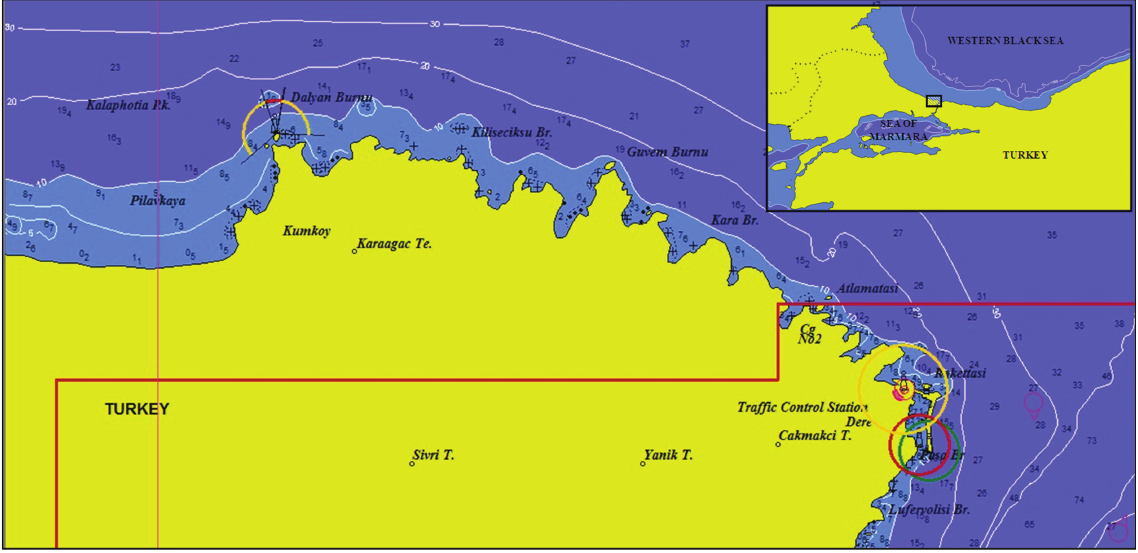
Figure 1: Study area: The Western Black Sea.